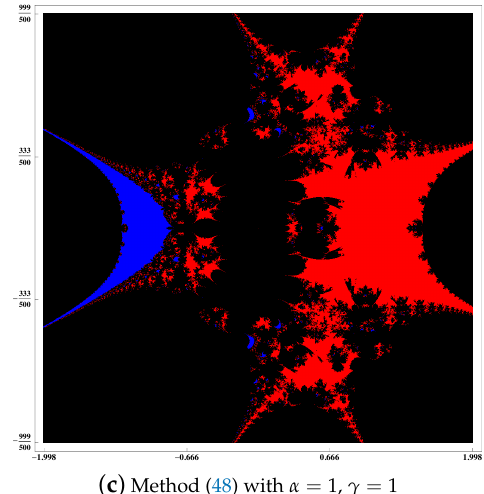
Figure 2. Basins of attraction associated to the method (48) applied to polynomial p ( z ) = ( z − 1 ) 2 ( z + 1 ) with different values for tolerance.